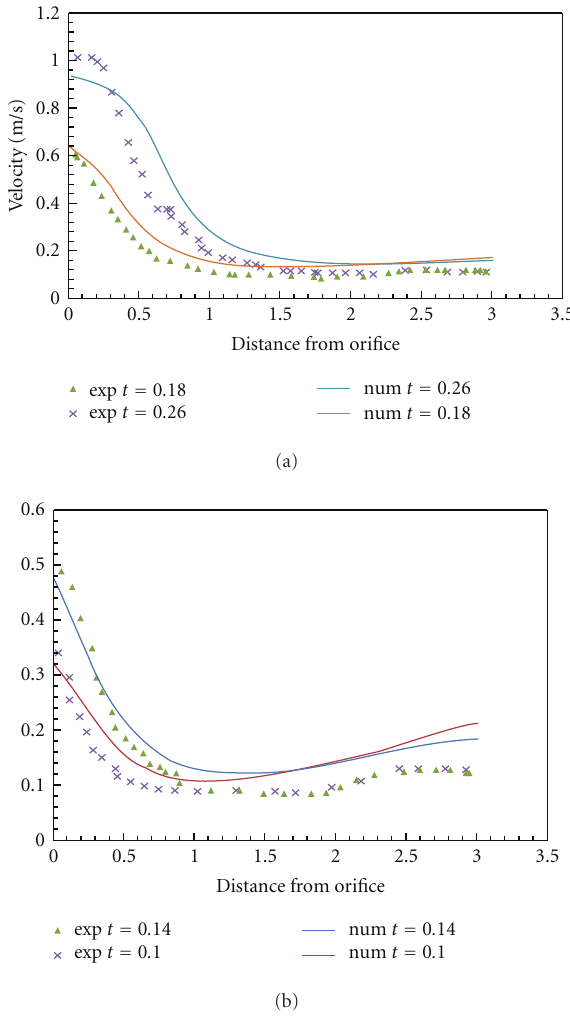
Figure 7: Comparison of experimental and numerical streamwise component of velocity profiles along the jet centreline during the four phases of the expulsion